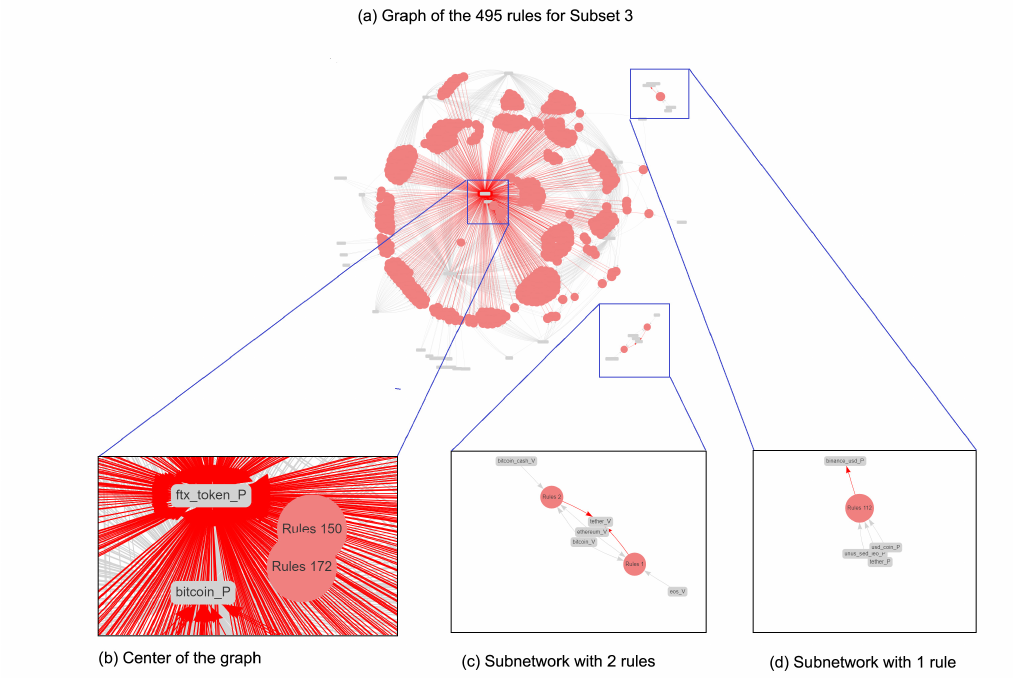
Figure 13. ( a ) Directed graph of the 495 rules for Subset 3, ( b ) Center of the graph that shows the mains items as consequences: FTX Token and Bitcoin, ( c ) Sub network with rules 1 and 2, and ( d ) Sub network with one rule (rule